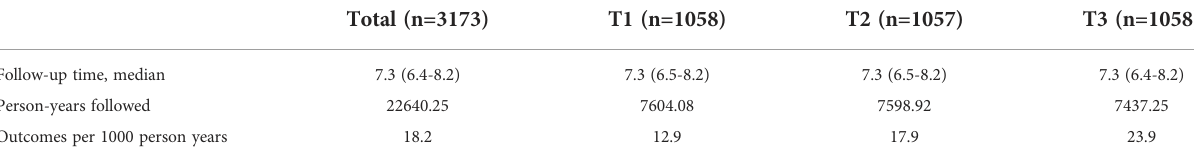
TABLE 2 Follow-up time and incidence of primary outcomes in total patients and tertiled by plasma aldosterone concentration.